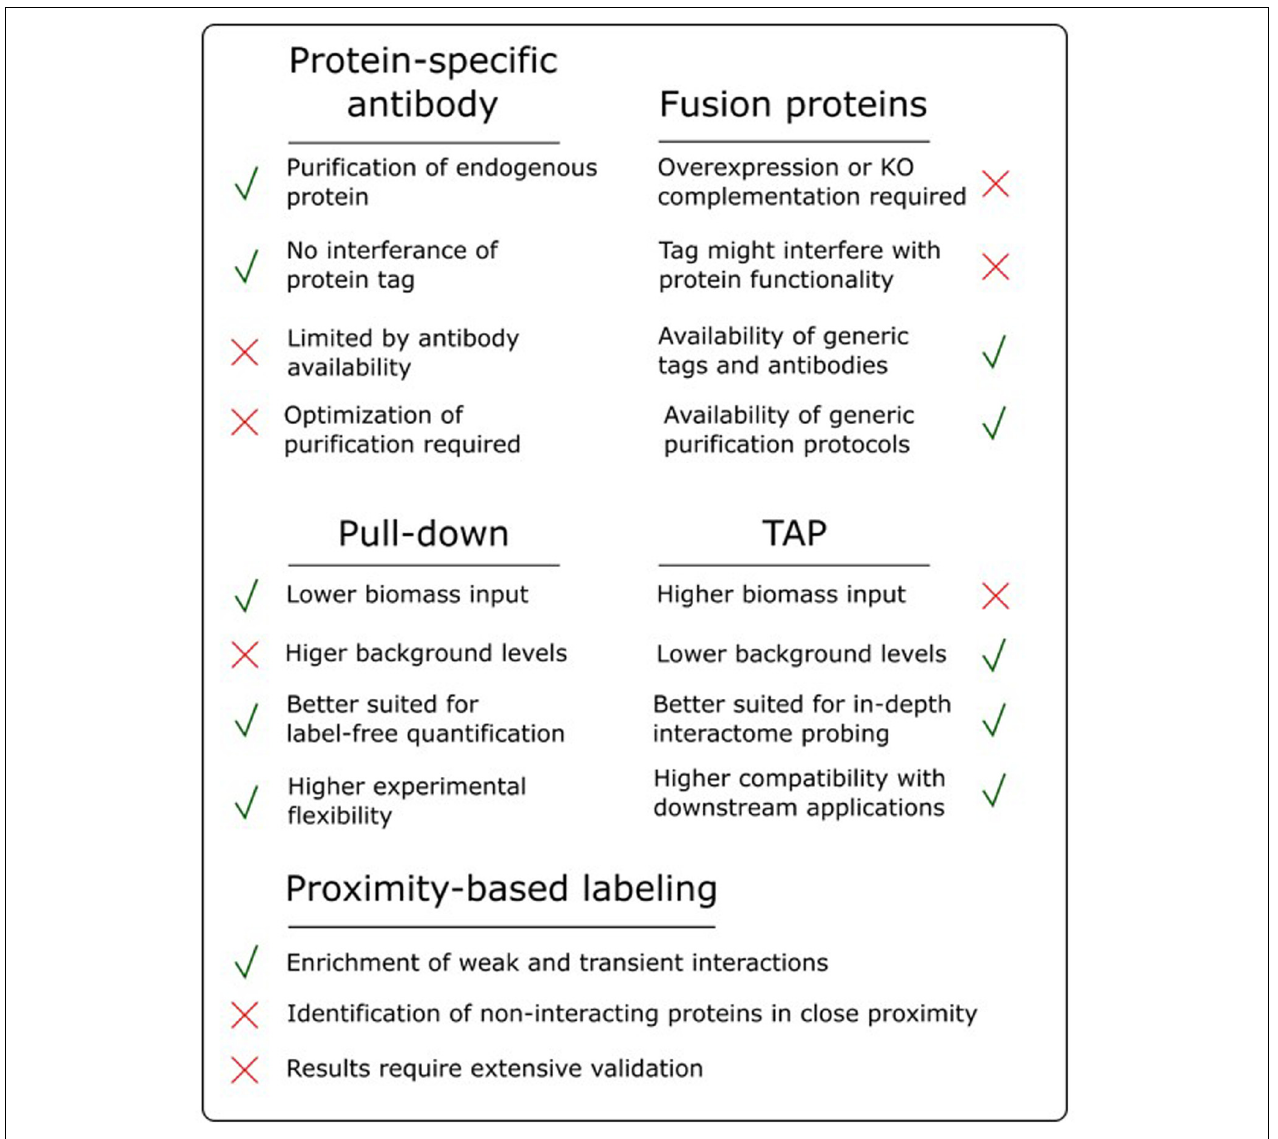
FIGURE 3 | Overview of the advantages and disadvantages of various AP/MS